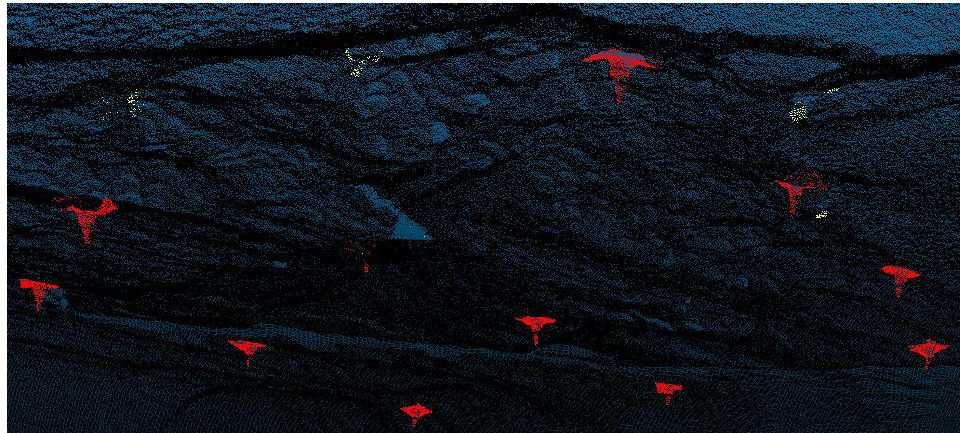
Figure 1. Application of point cloud on bolt detection in the mining